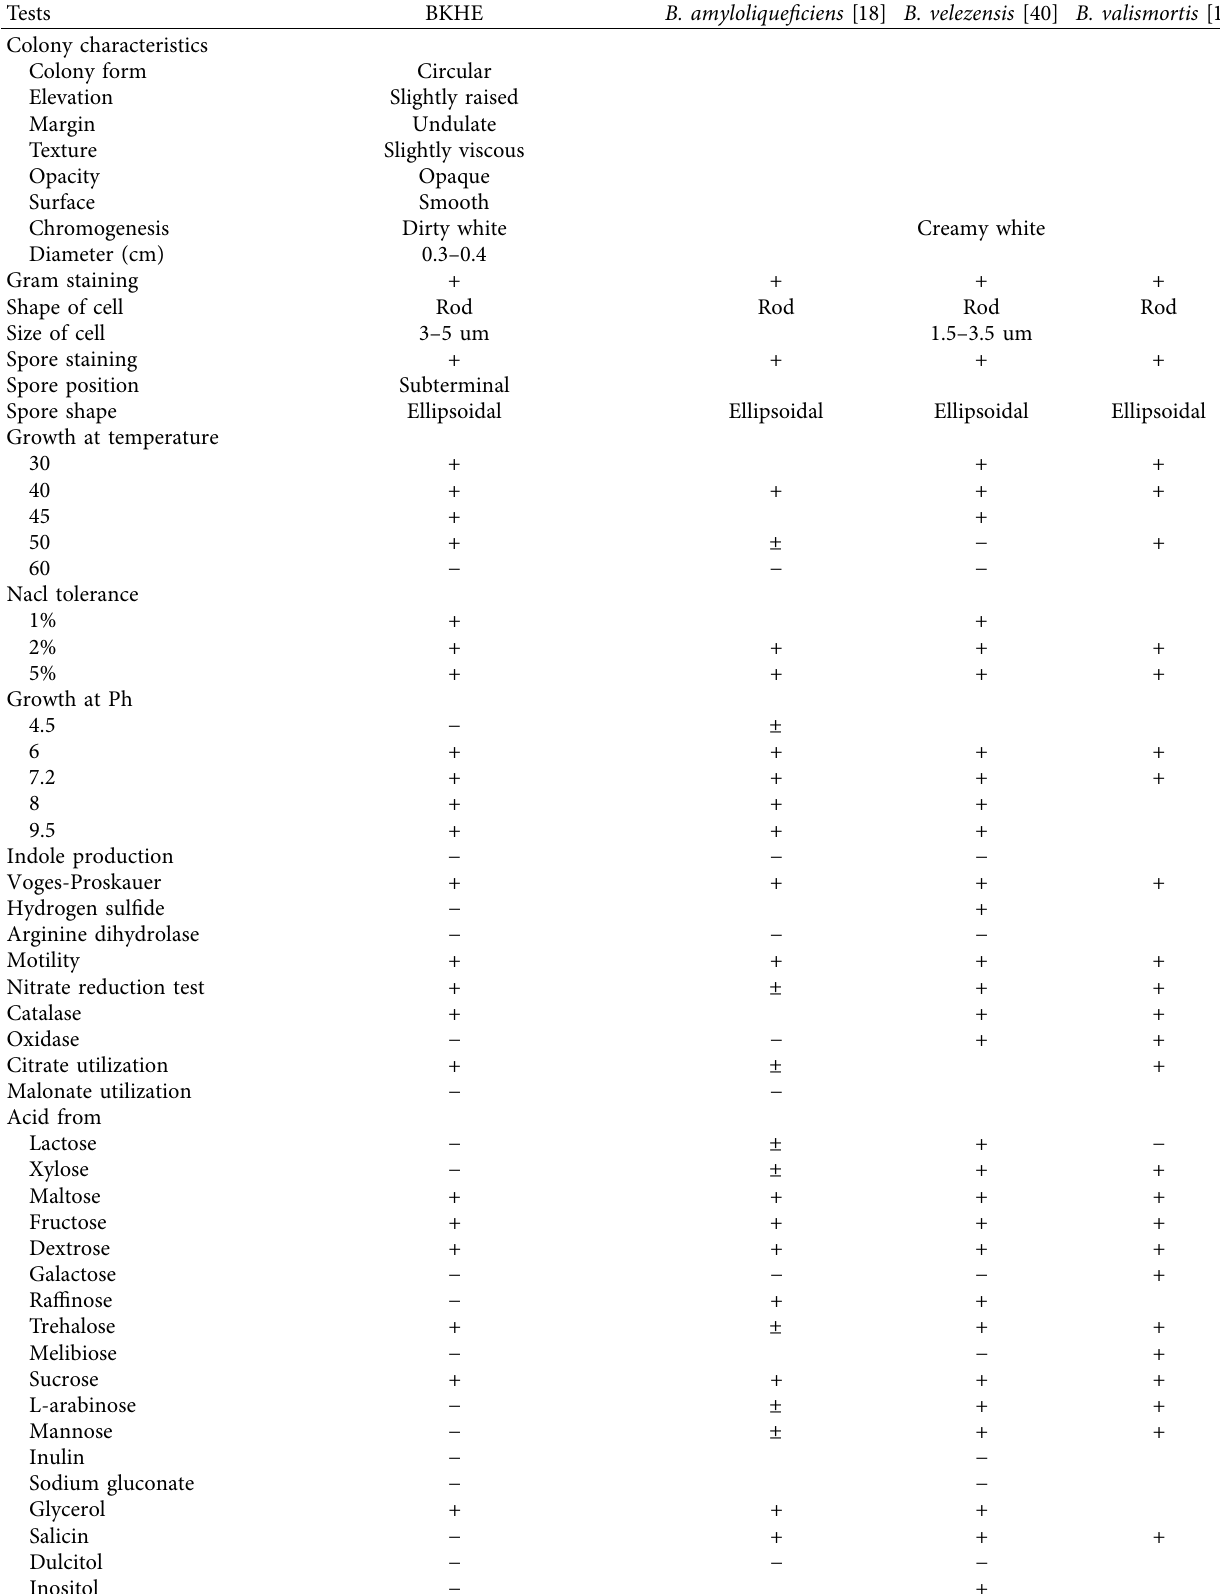
Table 2: Phenotypic features of selected isolate and comparison with closely related species based on BLAST